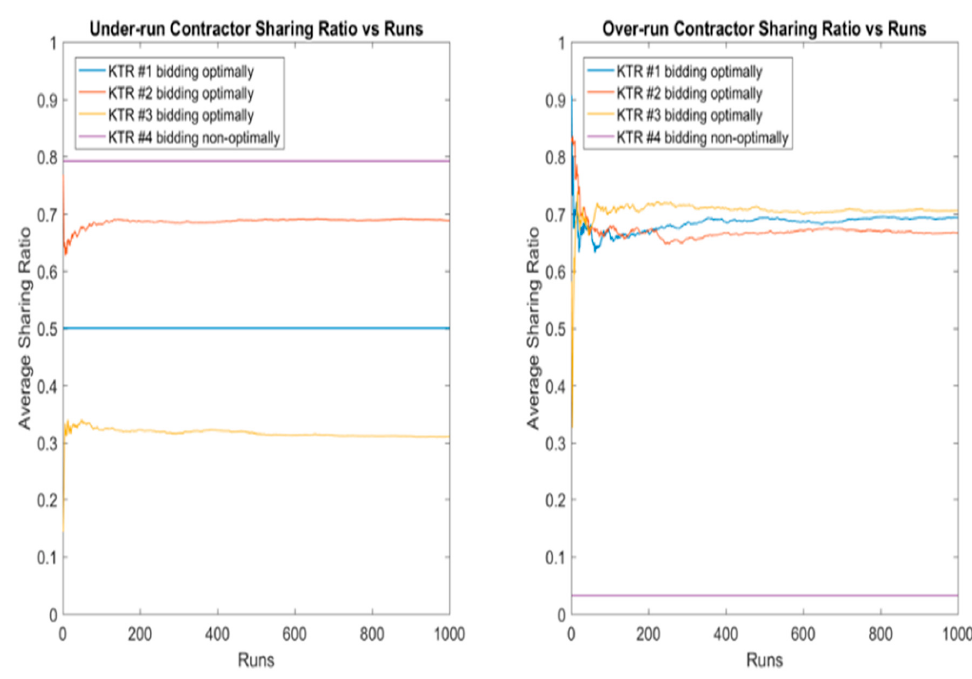
Figure 15. CPIF DAA-AWGE Average Sharing Ratios. Mathematics 2018 , 6 , x